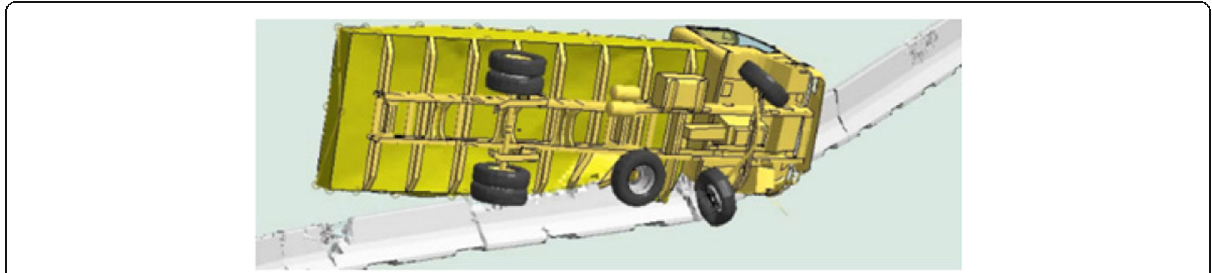
Fig. 6 Vehicle breaks through a barrier during a simulation test